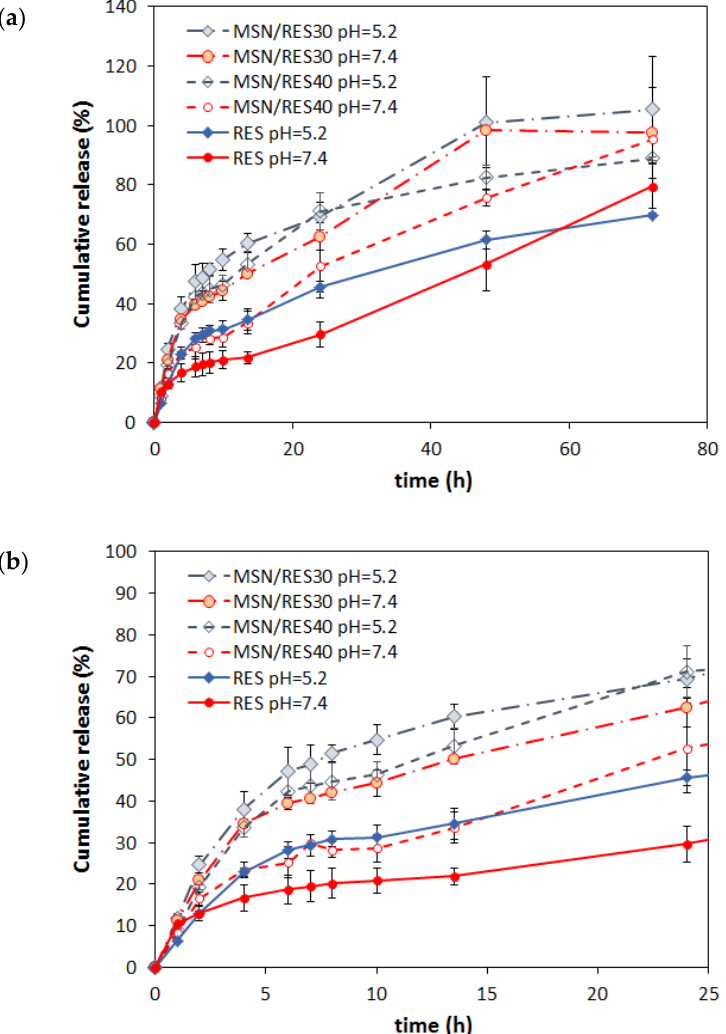
Figure 6. Cumulative release of resveratrol from the non-encapsulated (RES) and encapsulated samples (MSN/RES30 and MSN/RES40) at pH 7.4 and 5.2. ( a ) Full profile for 72 h and ( b ) the first 24 h.